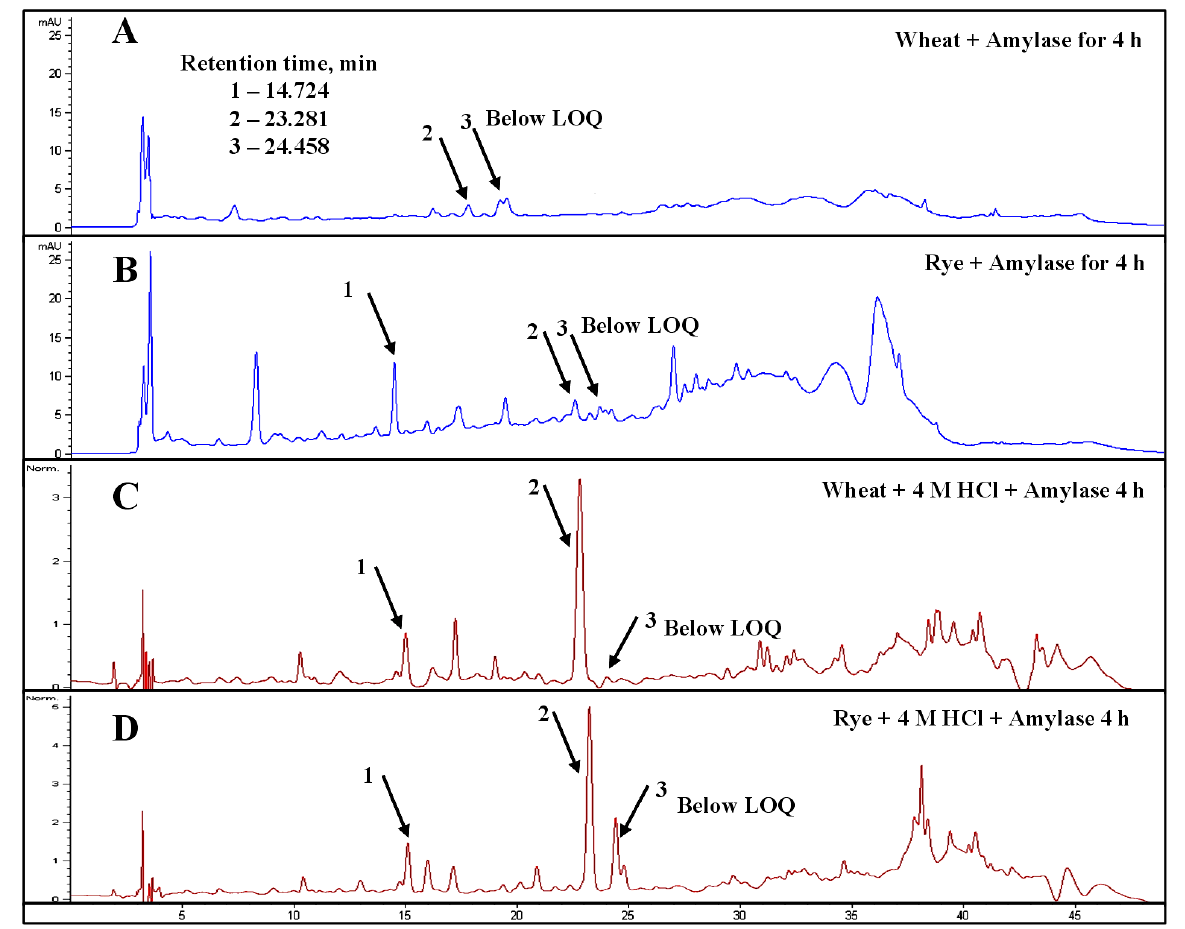
Figure 5. HPLC-DAD/MS n chromatograms of the hydrolysates upon EH of wheat ( A ) and rye ( B ) bran with AMY for 4 h and digestates after acidic hydrolysis with 4 M HCl of wheat ( C ) and rye ( D ) bran for 4 h followed by EH accomplished by AMY within additional 4 h. Note: peaks 1, 2, and 3 correspond to caffeic, p -coumaric, and ferulic acids, respectively. Hydroxycinnamates were monitored at 320 nm in a negative ionization mode. The identification of compounds of interest was based on their retention times and mass spectra in full scan mode (MS).